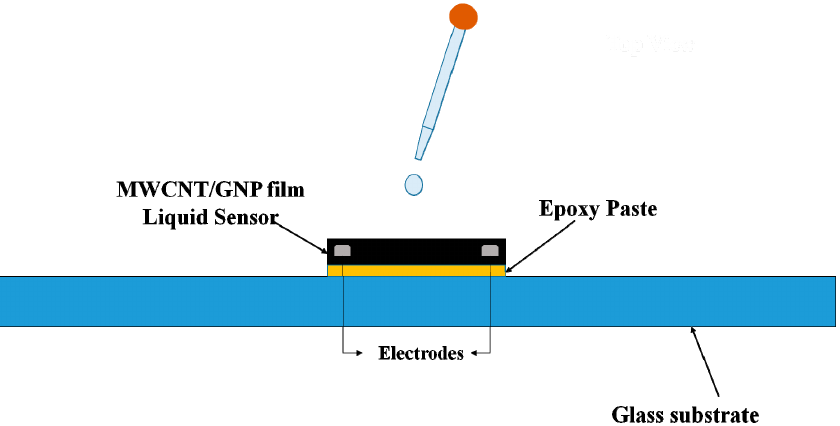
Figure 14. Schematic diagram of the titration test on the hybrid film.